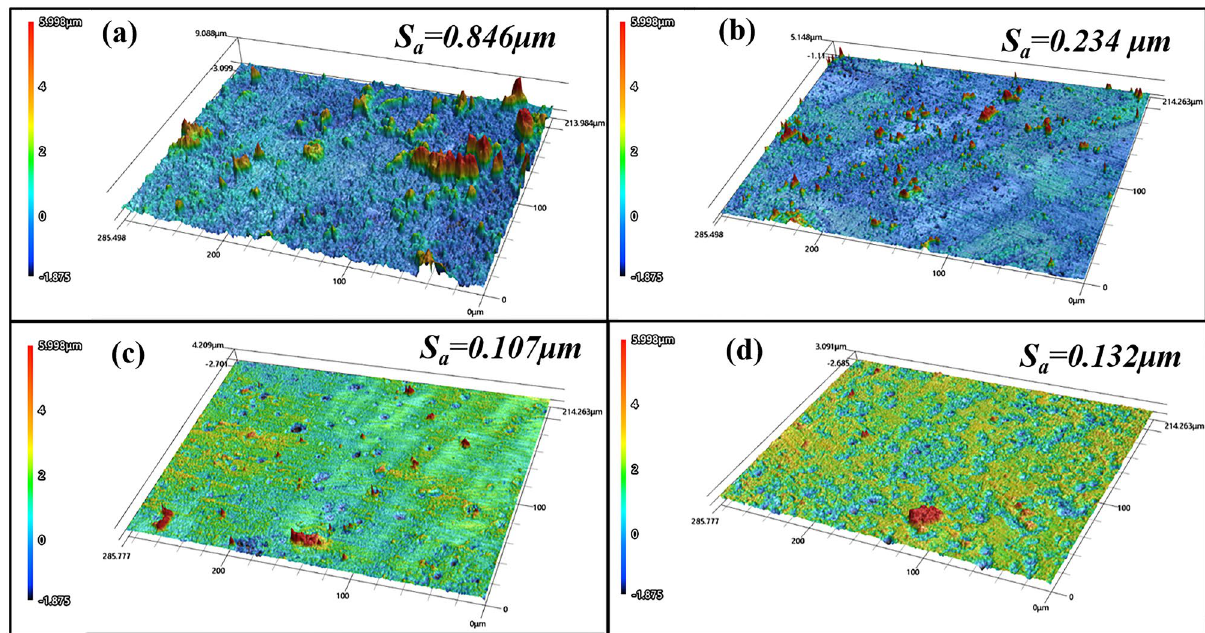
Figure 6. Roughness analysis of surface of AZ91 Mg alloys after immersing in 3.5 wt% NaCl solution ( a ) without and with addition of ( b ) 2 g/L GUE ( c ) 2 g/L PDE ( d ) 2 g/L TOE for 24 h under normal atmospheric